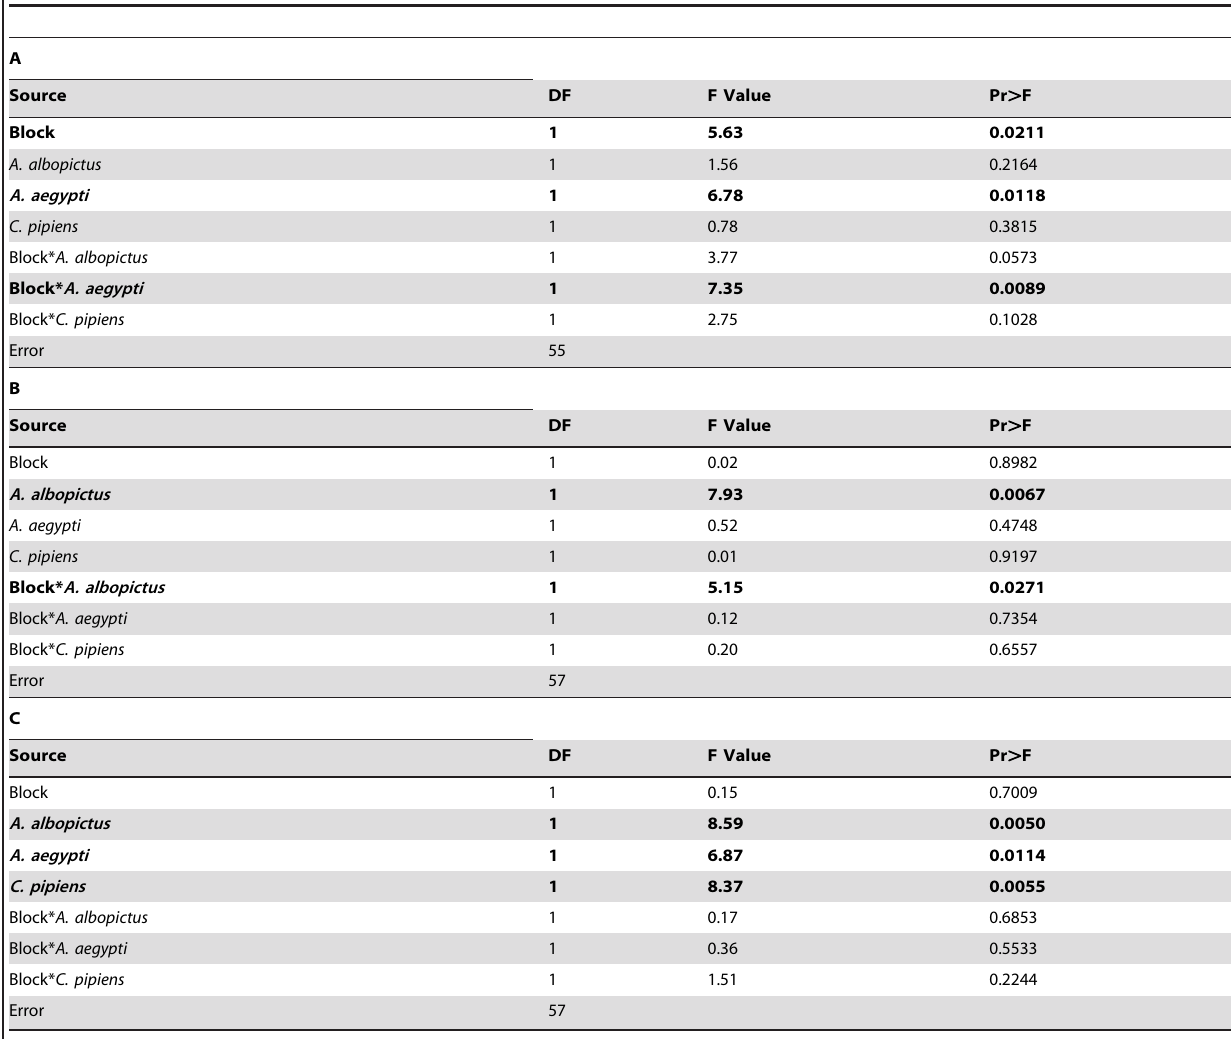
Table 4. Linear model results and parameter estimates for effects of block and species densities on l 9 for (A) Aedes albopictus ,